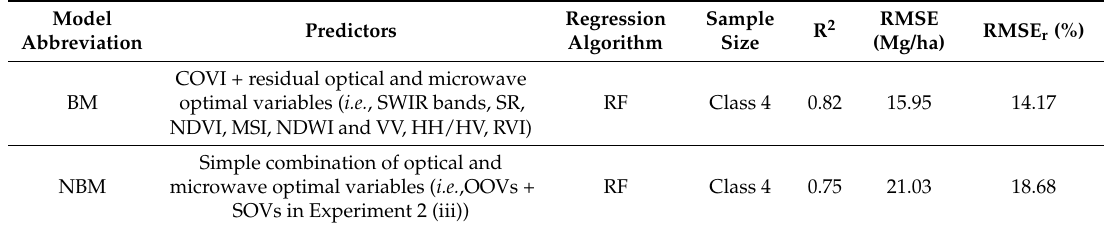
Table 2. Performances of the models (BM) based on COVI and residual optical and microwave optimal variables in Experiment 3 and the models (NBM) which performed best in Experiments 1 and 2.